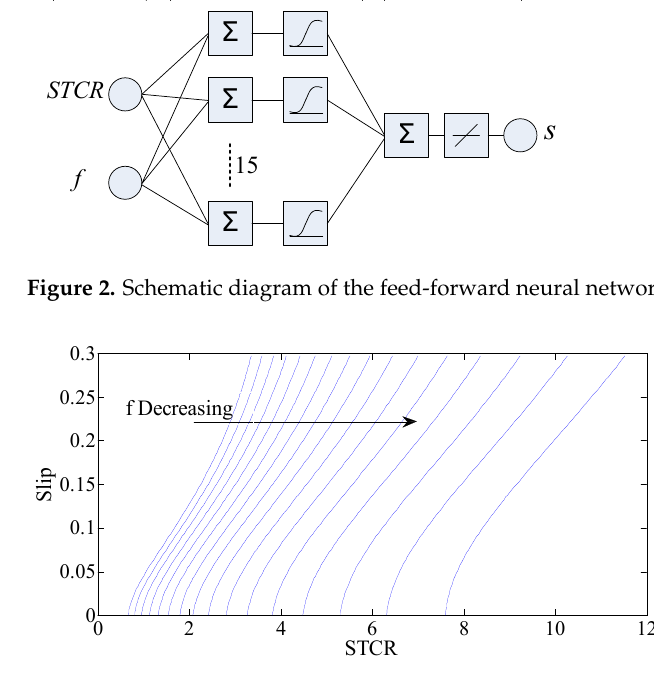
Figure 3. Slip versus STCR with frequency as a parameter.